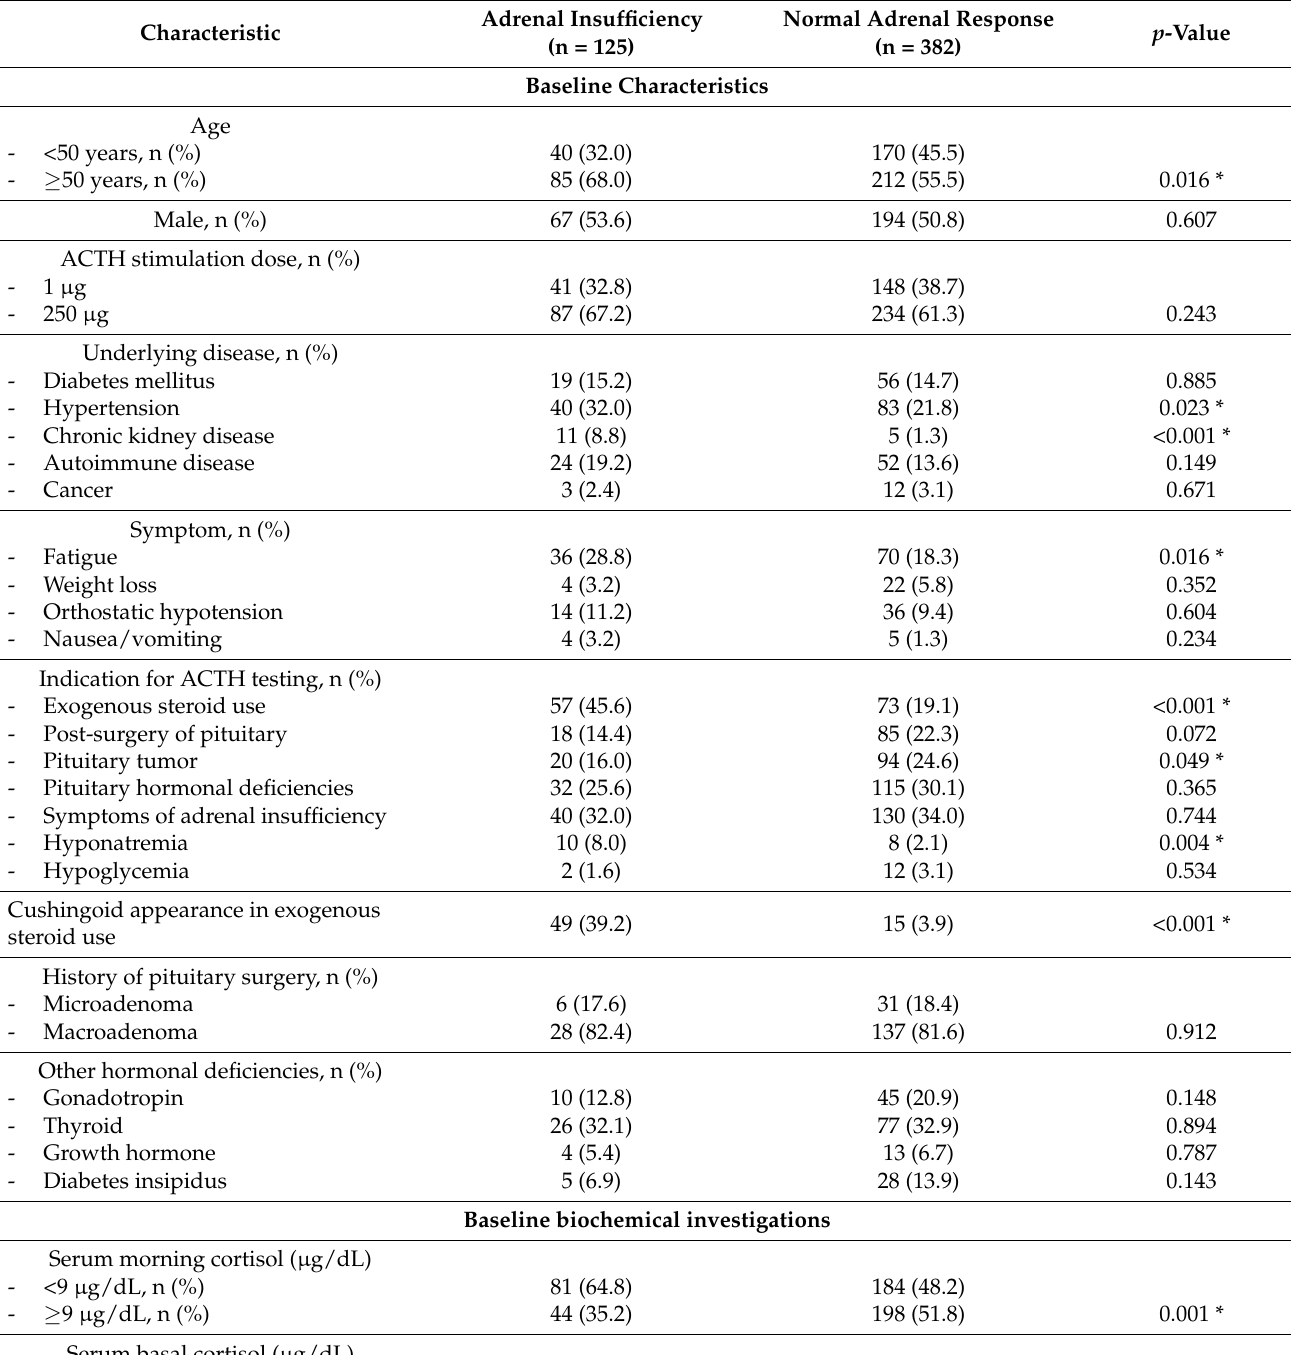
Table 1. Baseline characteristics and biochemical investigation results of patients with adrenal insufficiency (n = 125) and normal adrenal response (n =